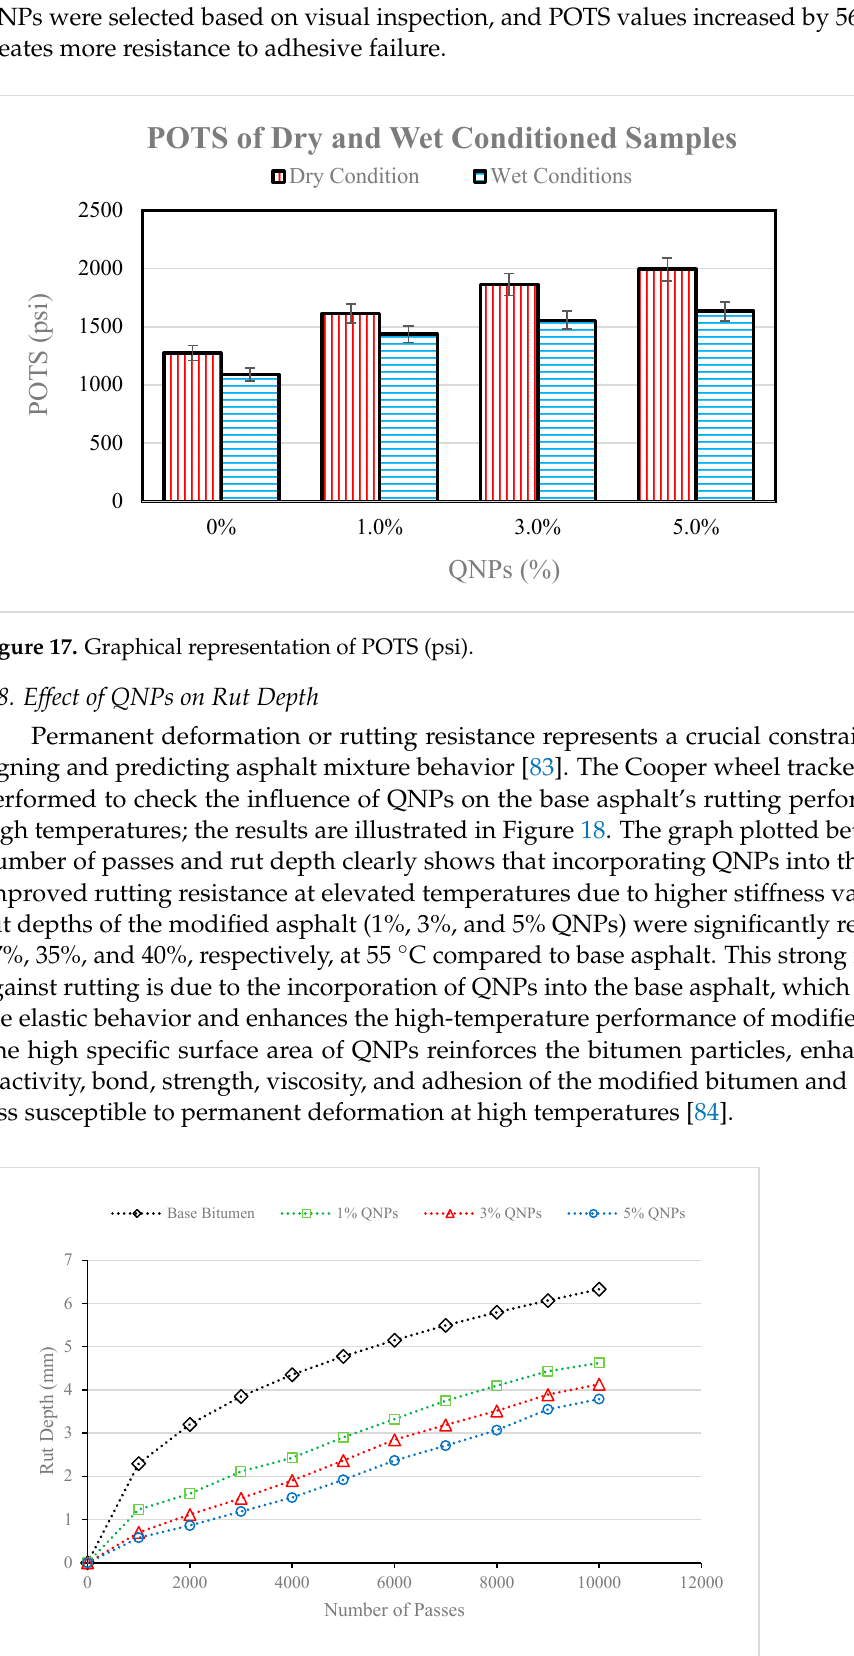
Figure 16. ( a , c , e , g ) 0%, 1%, 3%, and 5% QNPs, respectively, before burst; ( b , d , f , h ) 0%, 1%, 3%, and 5% QNPs, respectively, after burst.